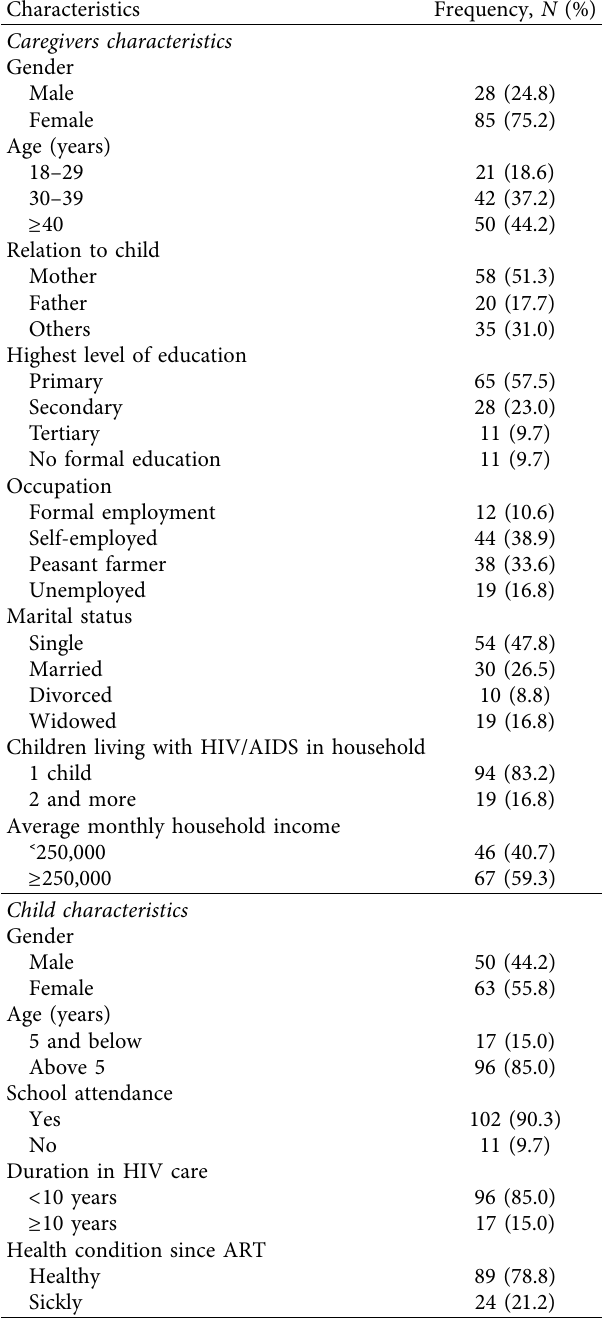
Table 1: Sociodemographic characteristics of study participants.